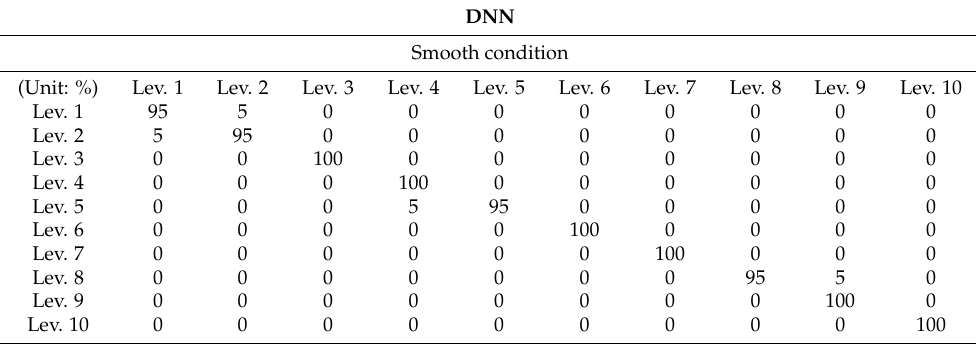
Table A2. Confusion matrices for the DNN model in three surface